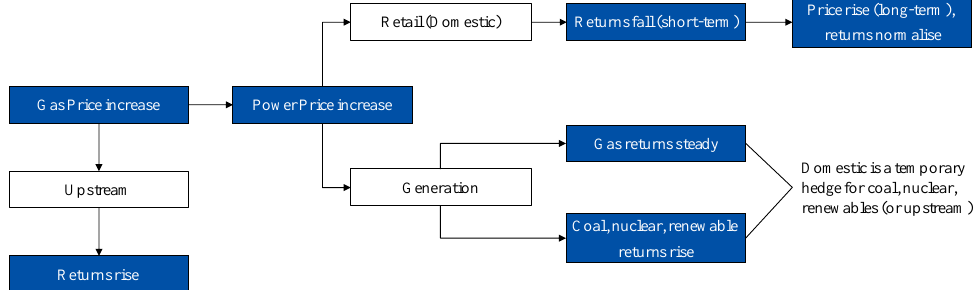
Figure 12. Demonstration of E&P and generation business acting as a hedge for the retail business (in the UK). Own illustration, based on RWE internal information.